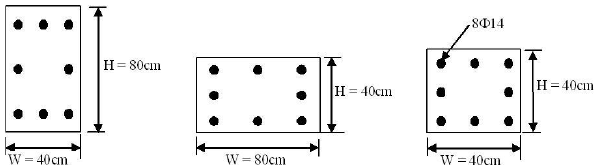
Fig. 7. Cross-section ratios (SR) considered for parametric analysis: SR=2 (left), SR=0.5 (centre), and SR=1